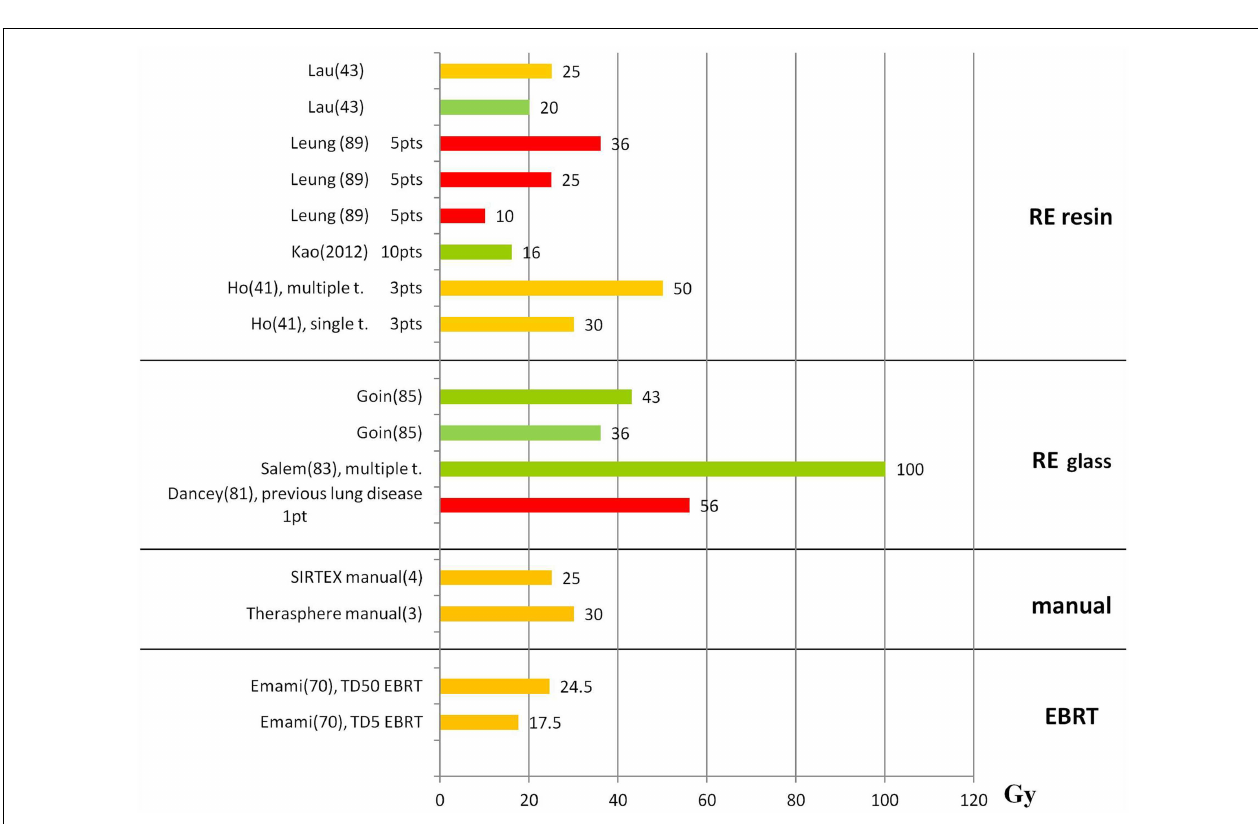
average factor of 0.6 (12). Red bars represent radiation-induced pneumonitis leading to death; orange bars represent the threshold for observed radiation-induced pneumonitis or the limit recommended by the author; green bars represent tolerated absorbed doses.The references are reported in parenthesis after the name of the first